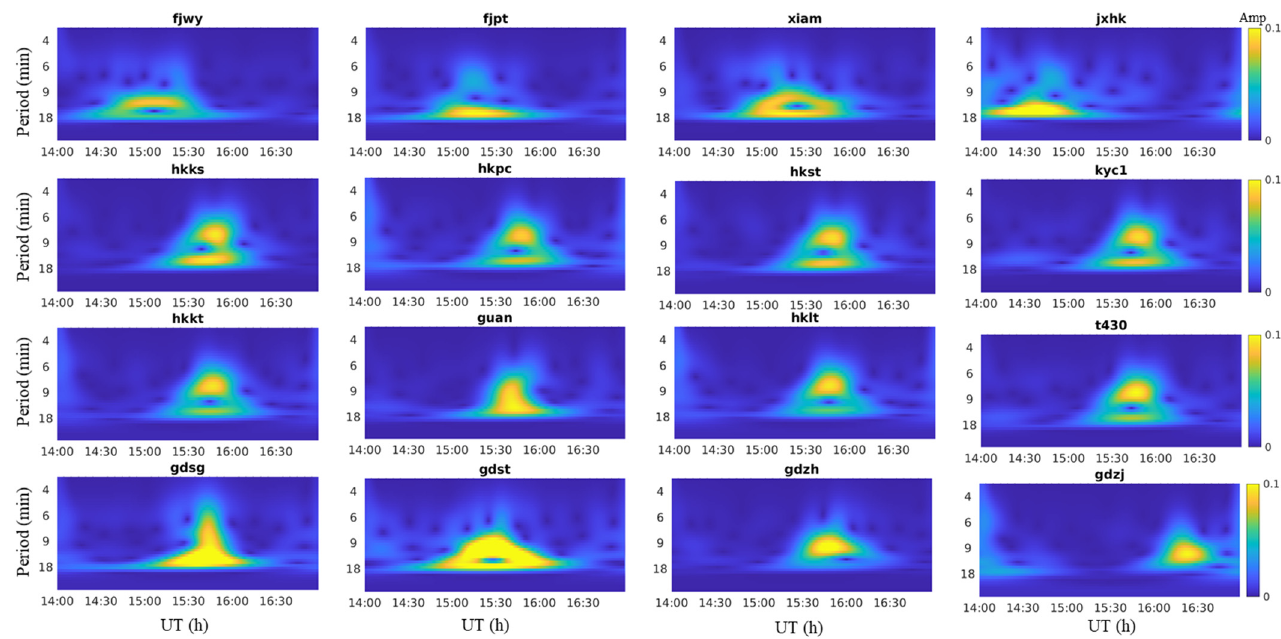
Figure 7. Wavelet analysis of PRN 5 from multiple station observations on 3 April 2019 to explore GW perturbation periodicities.